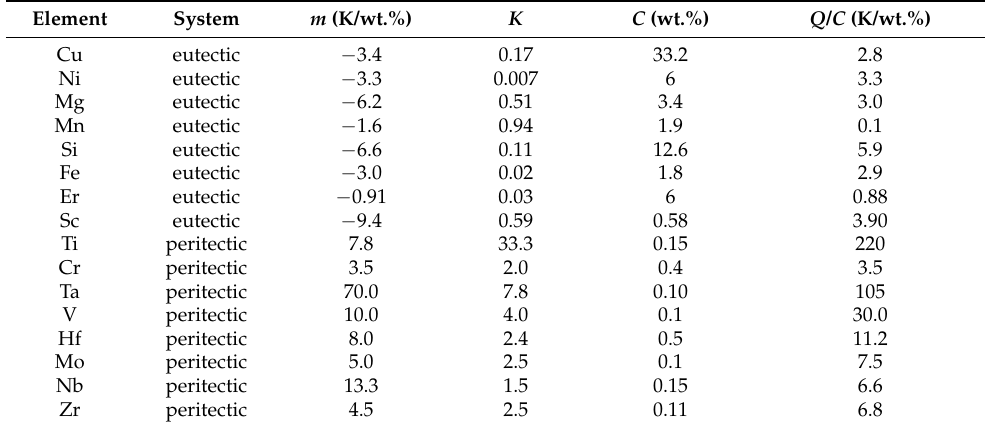
Table 1. Parameters underlying the calculation of Q for different solutes in aluminum